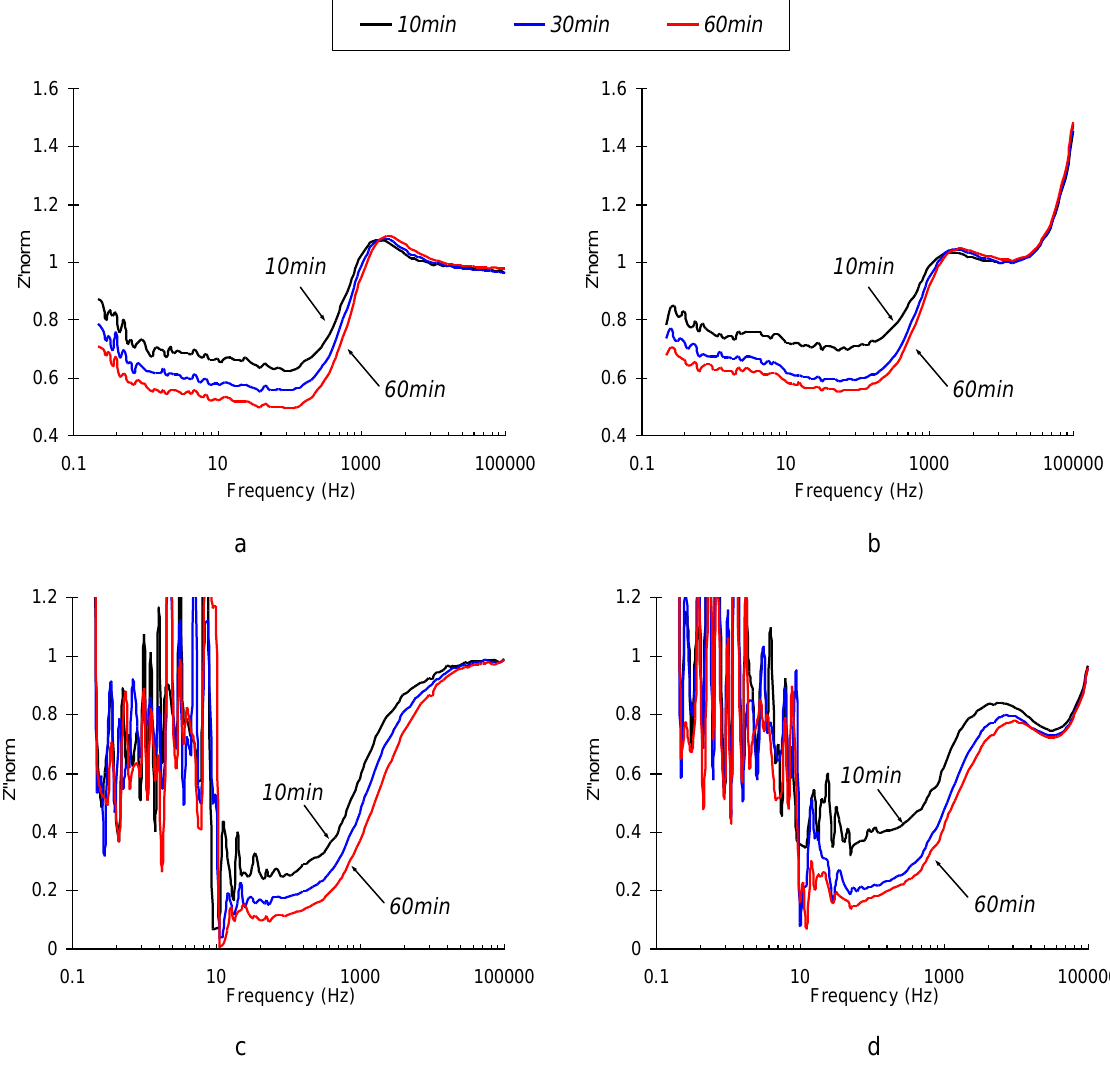
Figure 6. Normalized values of Z’ (a,b) and Z” (c,d) parts of the electrochemical impedance spectrum of a SEB immunosensor polarized at Δ φ = +0.1 V vs. Ag/AgCl in 0.3% NaCl (a,c) and 0.3% NaCl +10 g/mL SEB (b,d) media as a function of time (10 min, 30 min and 60